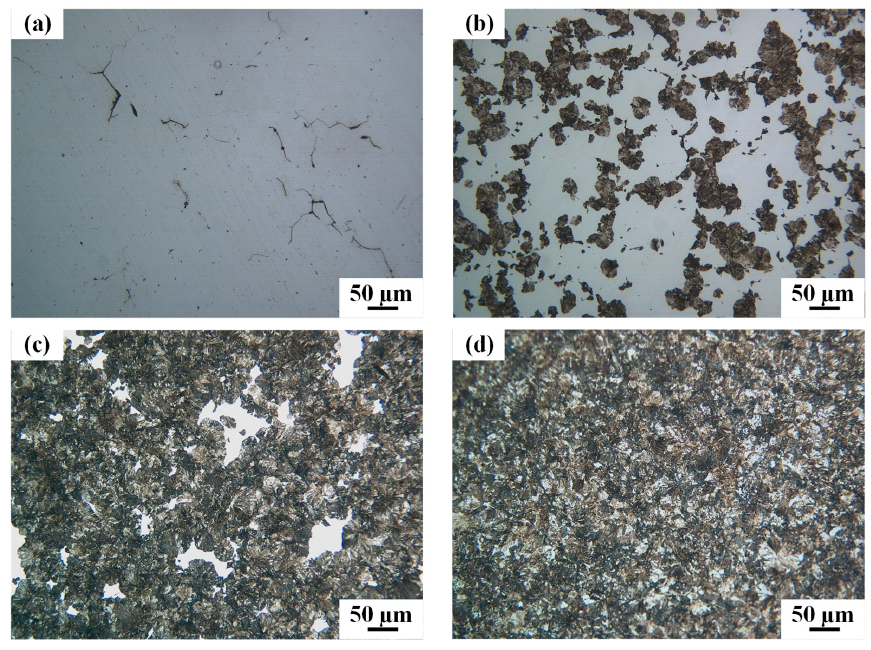
Figure 8. Optical microscopy of the microstructure at different moments of the isothermal transformation at T = 550 °C after austenitizing at 880 °C. The samples were quenched to room temperature after 5 s ( a ), 10 s ( b ), 15 s ( c ), and 20 s ( d ).